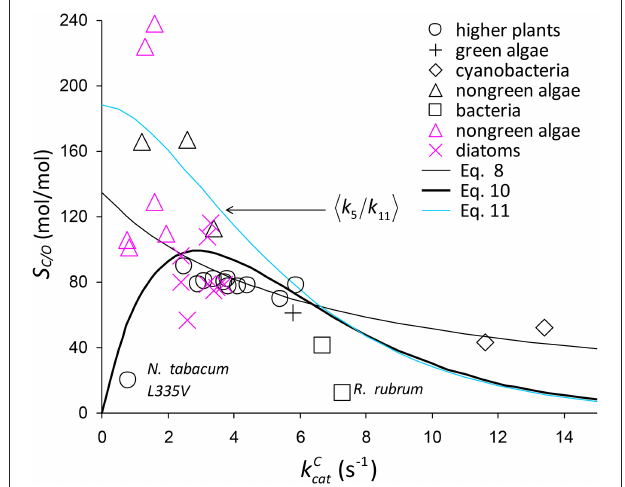
S C / O given by Equation (8) and D E k 5 k 11 E (Equation 11). D